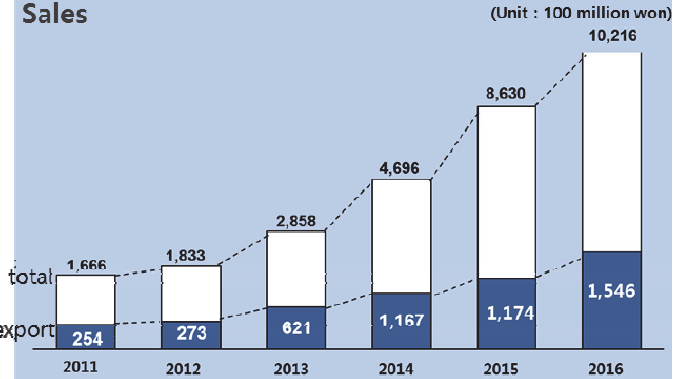
<Figure 3> Sales of growth of Dongwon